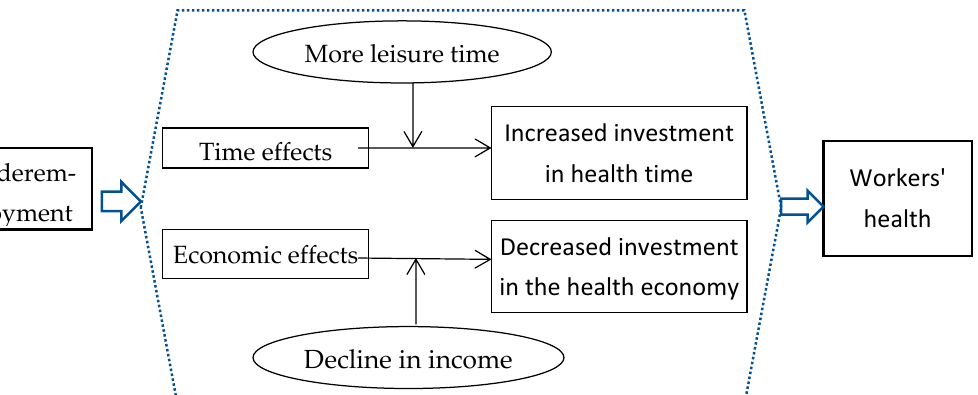
Figure 1. Theoretical framework.